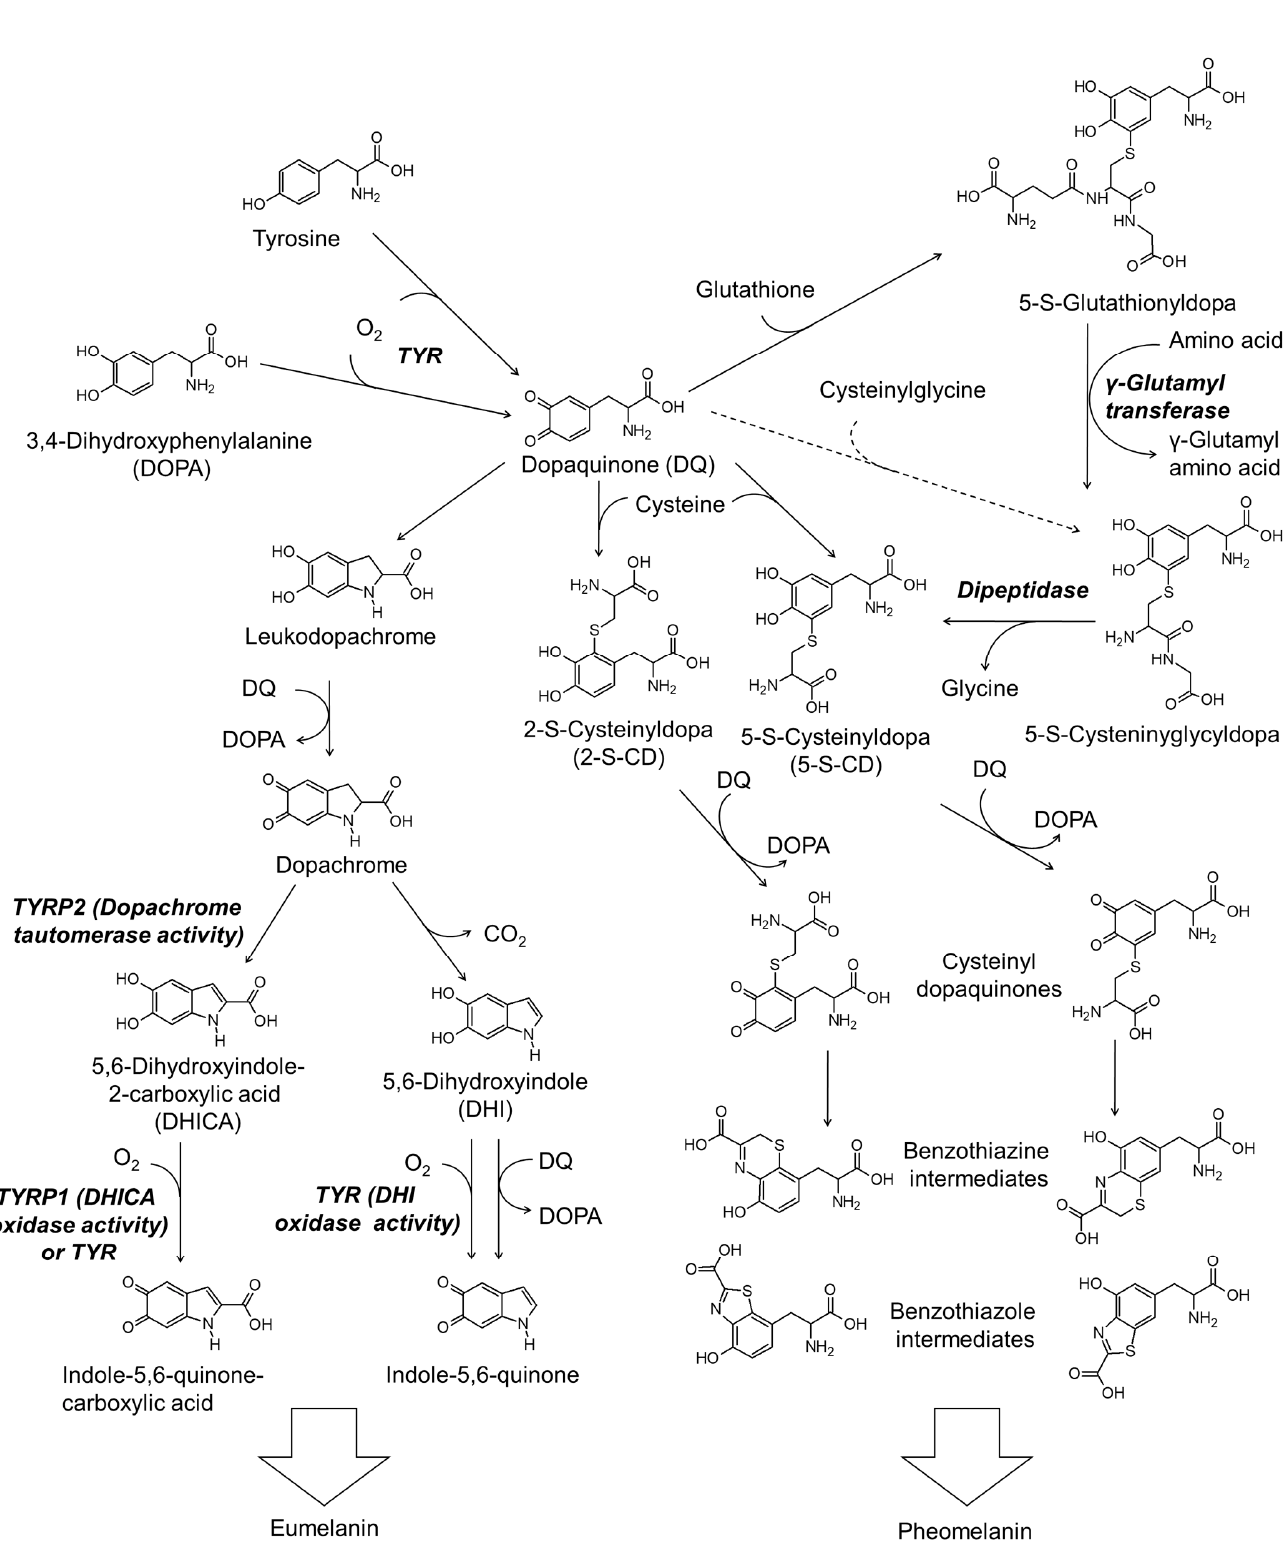
Figure 2. The biosynthetic pathways for eumelanin and pheomelanin. TYR, tyrosinase; TYRP1, tyrosinase ‐ related protein 1; TYRP2, tyrosinase ‐ related protein 2. Glutathione can react with DQ to produce 5 ‐ S ‐ glutathionyl dopa and 2 ‐ S ‐ glutathi ‐ onyl dopa in preference of the former [86]. 6 ‐ S ‐ Glutathionyl dopa is also formed at a lower yield (5%) compared to 5 ‐ S ‐ glutathionyl dopa (76%) and 2 ‐ S ‐ glutathionyl dopa (12%) [86]. Carstam et al. showed that 5 ‐ S ‐ glutathionyl dopa is present in the homogenates of cul ‐ tured human melanoma cells at a hundred times lower molar concentration than that of